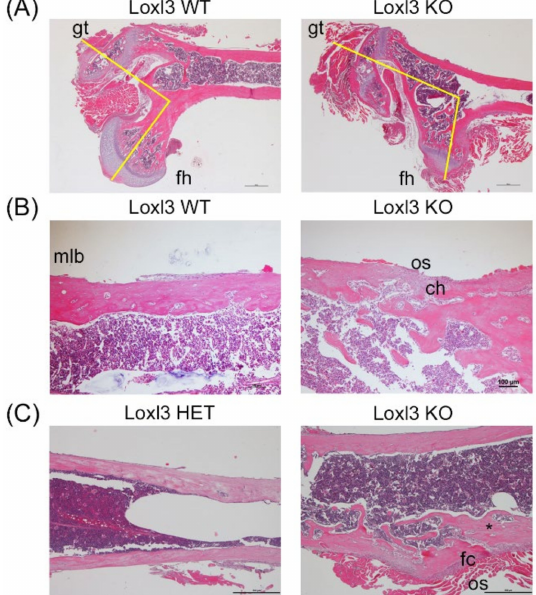
Figure 3. Embryonic loss of Loxl3 promotes abnormal skeletal development. ( A ) Images showing femoral head dysplasia found in several Loxl3 KO ( Loxl3 LacZ / LacZ ) mice with atrophy of the femoral head (fh), hypertrophy of the greater trochanter (gt) and an abnormal angle between the fh and gt, displayed by yellow lines. ( B ) The lamellar diaphysis bone in Loxl3 KO ( Loxl3 LacZ / LacZ ) animals is interrupted by woven bone, including few chondrocytes (ch) and active osteoblasts (os) in the periphery compared to the mature lamellar bone (mlb) in WT mice. ( C ) The diaphysis from Loxl3 KO ( Loxl3 LacZ / LacZ ) femur displays a fibro-cartilaginous (fc) area with local deformation and bone marrow disorganisation not present in a littermate heterozygous mouse (HET, Loxl3 + /LacZ ). The asterisk depicts a connective channel between the periphery and deep inter-trabecular spaces. Scale bars, 100 µ